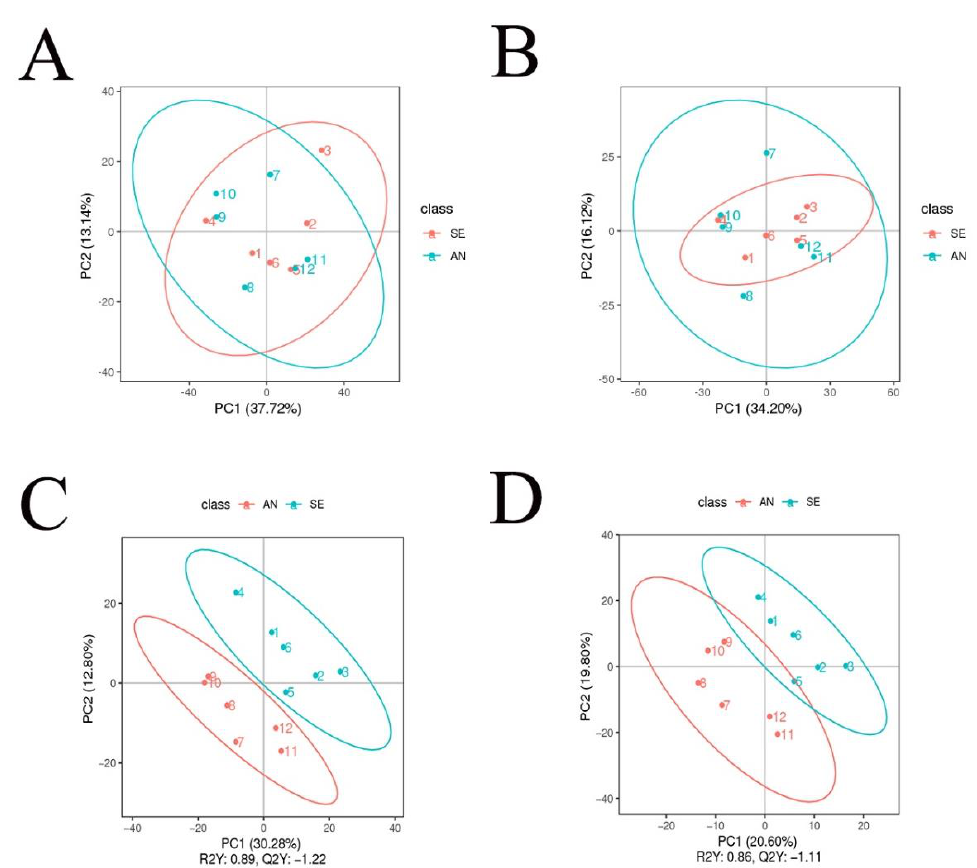
Figure 2. PCA scores plot of metabolites identified in positive polarity mode ( A ) and negative polarity mode ( B ). PLS-DA scores plot of metabolites identified in positive polarity mode ( C ) and negative polarity mode ( D ).